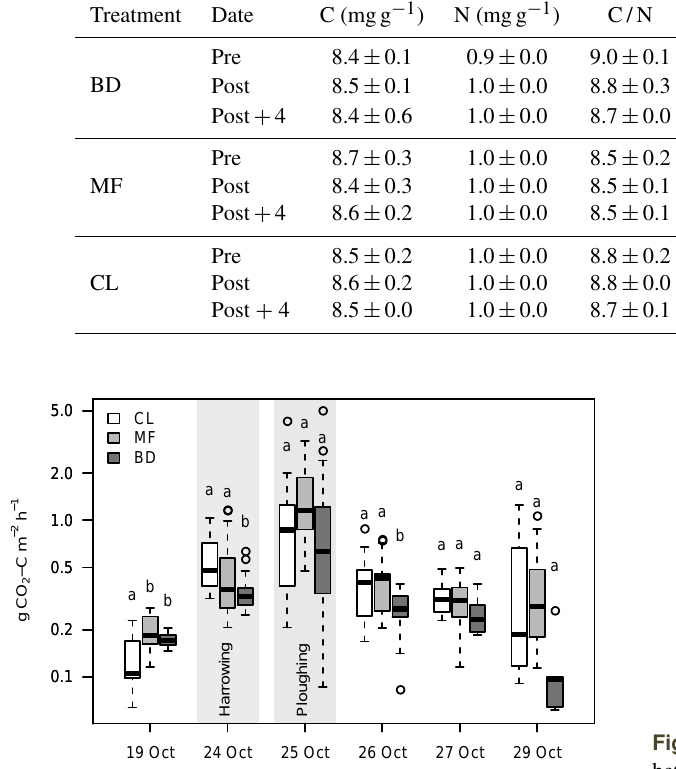
Figure 2. Soil CO 2 efflux and time of tillage operations (harrowing down to 10cm depth and ploughing down to 30cm depth). Note that, for the days of tillage (24 and 25 October), only the fluxes after tillage (distinguished by light-grey backgrounds) are included in order to gain a better attribution of the tillage effect. Different letters indicate significant differences (Tukey’s HSD test, p < 0.05) in mean fluxes of the treatments (CL, control; MF, mineral fertiliser; BD, biogas digestate) for each measurement day.